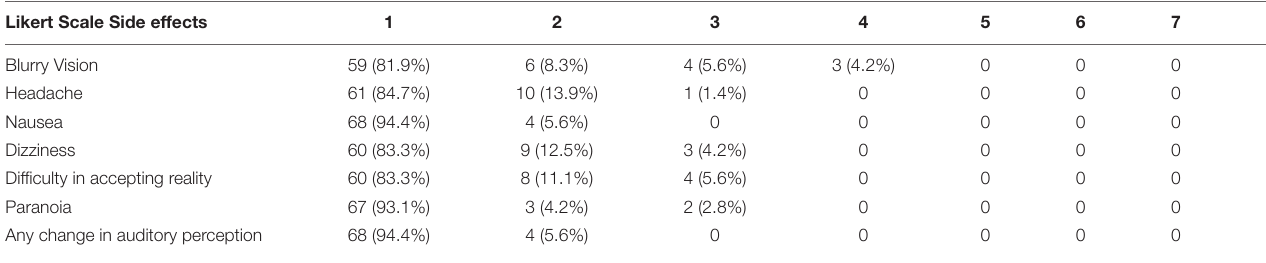
TABLE 4 | Assessing side effects of one session of experiencing Virtual Reality Simulation of